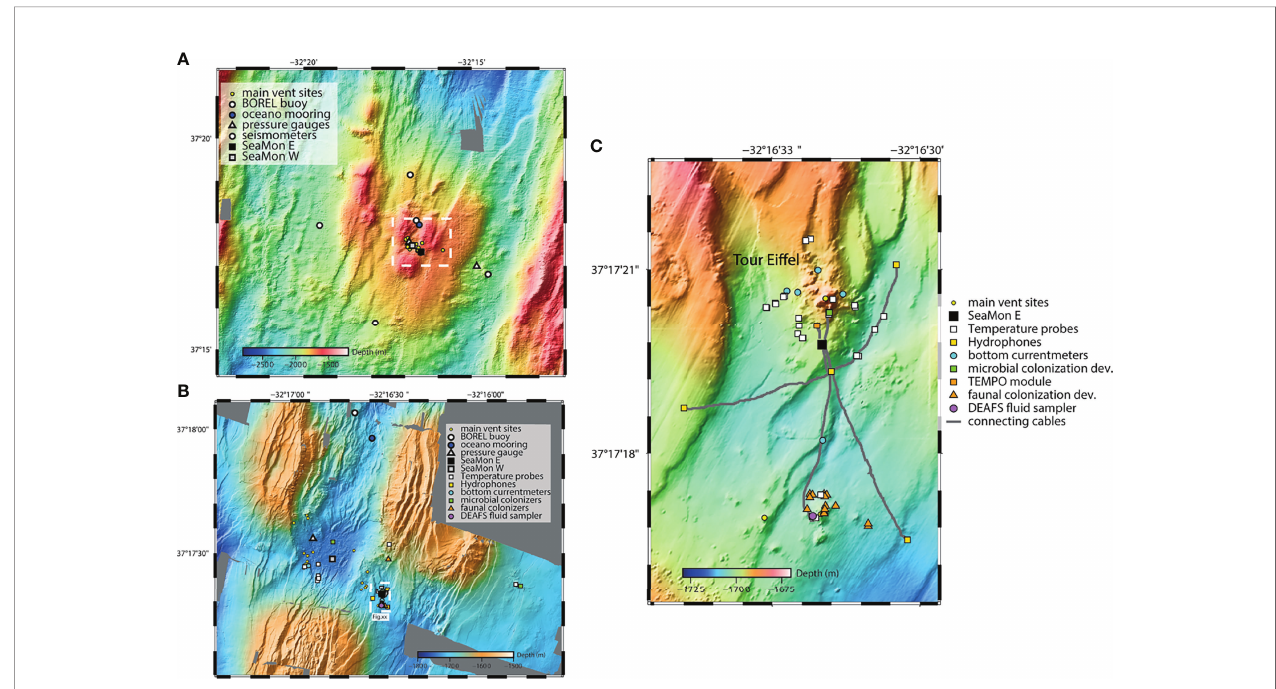
FIGURE 2 | The EMSO-Azores observatory displaying instruments location. (A) Segment of the Mid-Atlantic Ridge showing the location of the Lucky Strike vent fi eld. (B) The Lucky Strike vent fi eld showing the location of the EMSO-Azores observatory (area represented by the white dashed box in A ). (C) Detail of the instrumentation at Tour Eiffel (area represented by the white dashed box in B